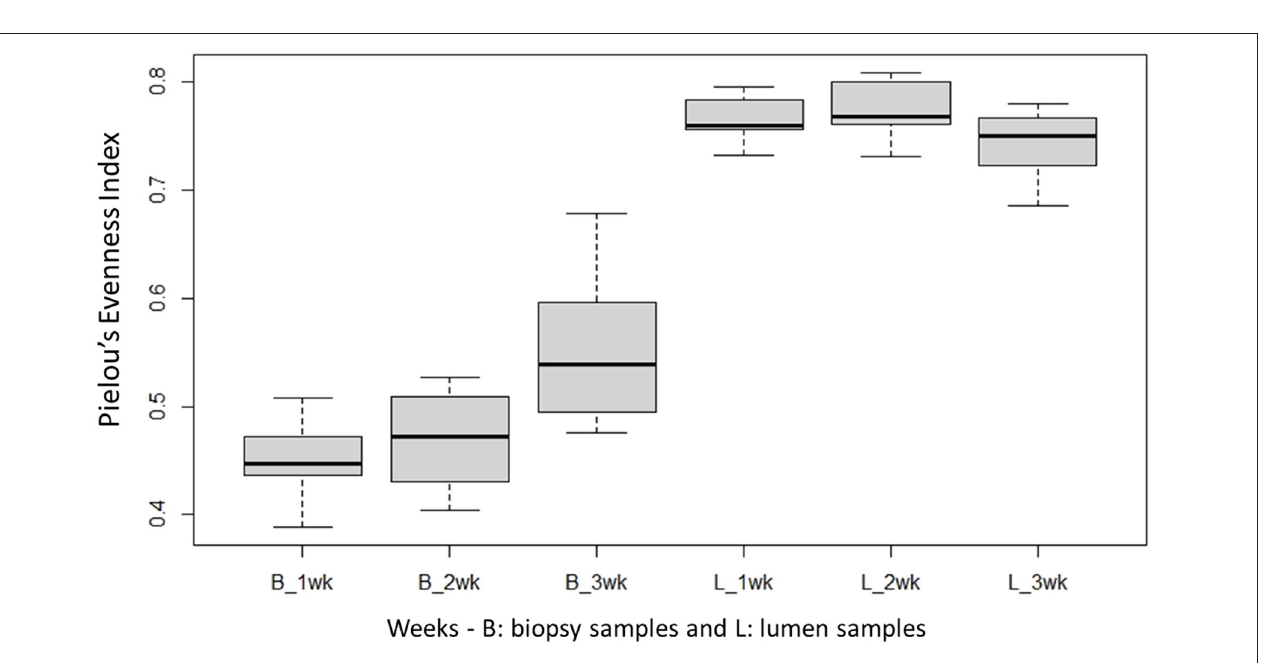
dissimilarity index was generated and valued at 0.112 ( Figure 5